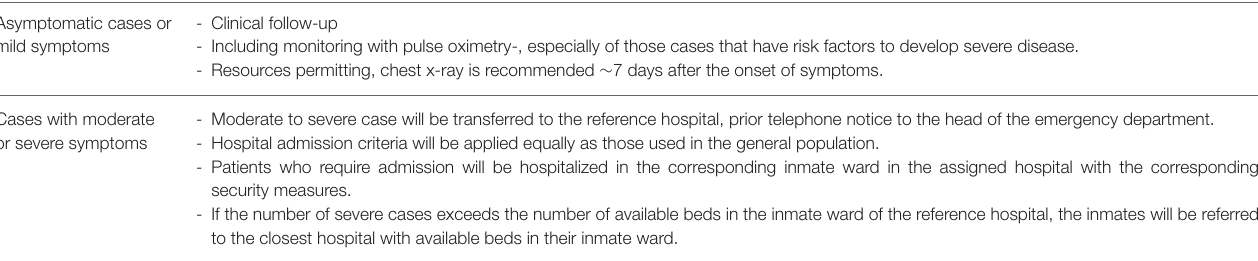
TABLE 4 | Guidelines used for the clinical management of confirmed cases of COVID-19 according to clinical severity during the COVID-19 outbreak in the CPAII Prison in Alicante, Spain (January-April 2021). Asymptomatic cases or - Clinical follow-up mild symptoms - Including monitoring with pulse oximetry-, especially of those cases that have risk factors to develop severe disease. - Resources permitting, chest x-ray is recommended ∼ 7 days after the onset of